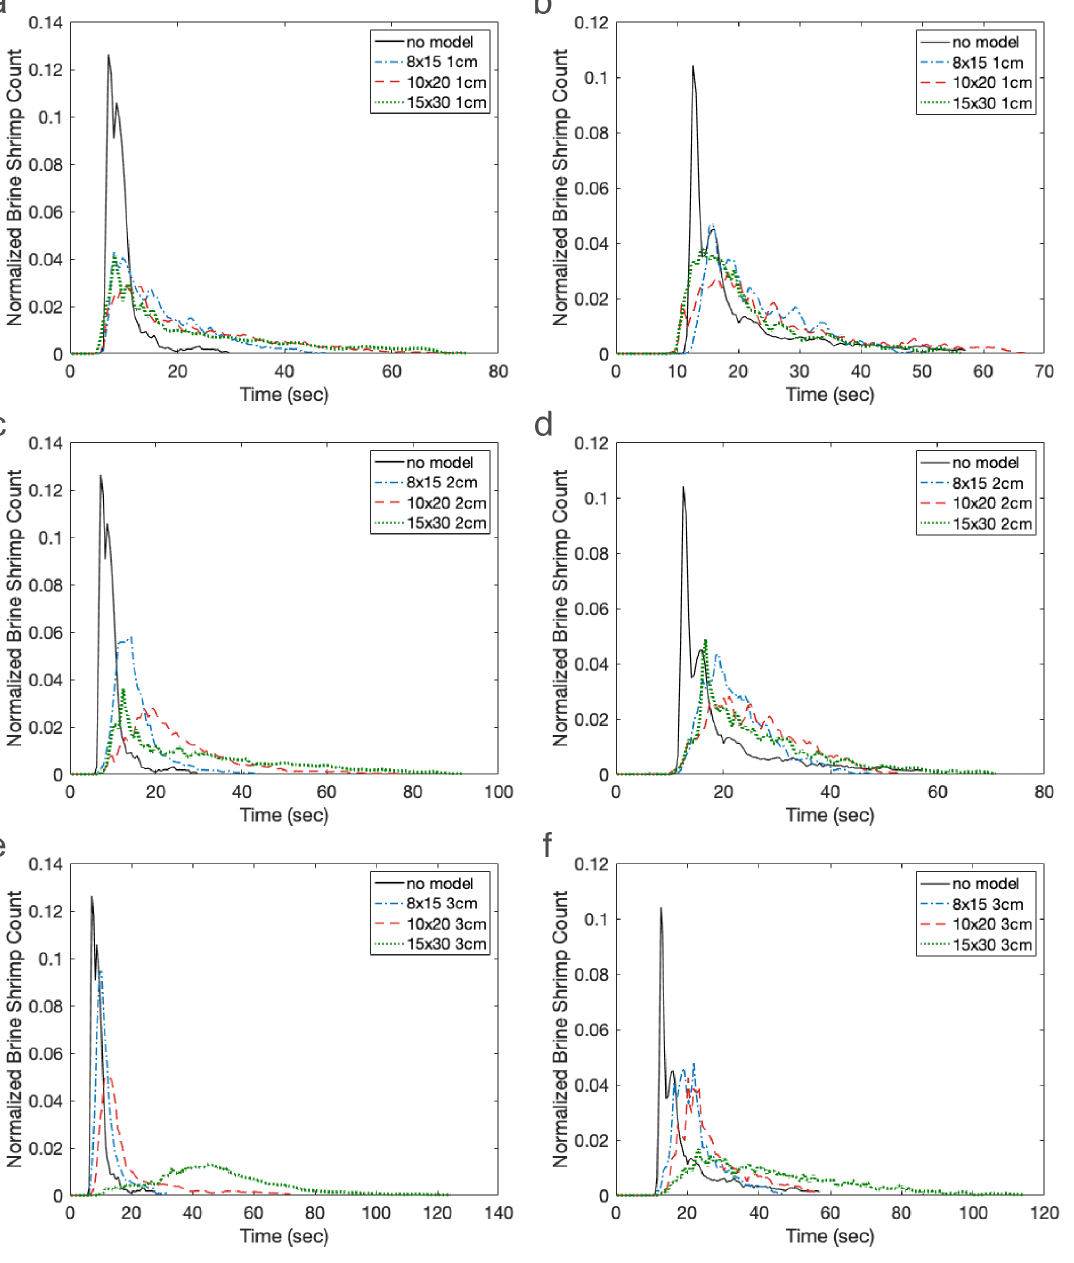
Figure 9. Normalized brine shrimp count over time in the green (left) and blue (right zones). Each panel shows models of the same height, namely: 1-cm cylinders ( a , b ); 2-cm cylinders ( c , d ); and 3-cm cylinders ( e , f ). The solid black lines show results for the no model case. Blue dotted-dashed lines, red dashed lines, and green dotted lines are for the 8 × 15, 10 × 20, and 15 × 30 models, respectively. The effect of cylinder height is less clear. As found in the CFD results, the density has a much larger effect on the bulk flow through the model than does the height. To better see differences in the distributions of brine shrimp in each zone as a function of time, Figure 10 shows the time from the start of the experiment that the brine shrimp appear in the green (left zone) and blue (right zone). In other words, the mean (red dot), median (red line), upper quartile, lower quartile, minimum, and maximum of the distributions in Figure 9 are presented. Note that this is not equivalent to the arrival times presented in the next section. These plots describe the times when brine shrimp typically appear